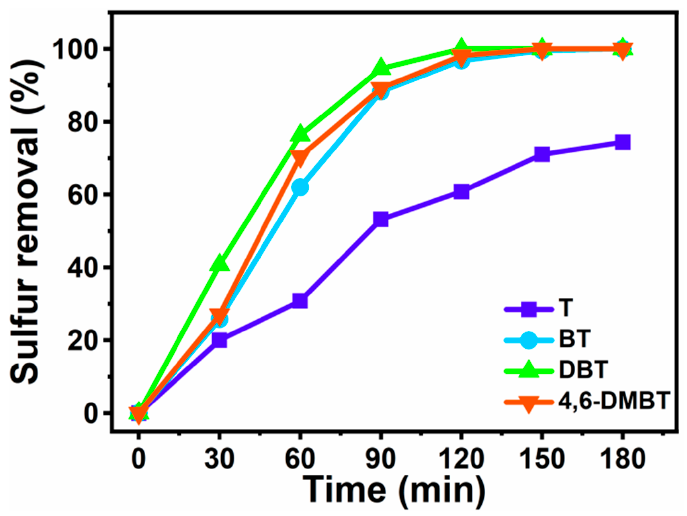
Figure 11. Removal of di ff erent sulfur-containing compounds in the desulfurization system. Experimental conditions: T = 60 °C, V DBT = 5 mL, V IL = 3 mL, O/S = 6, m([BMIM] 3 PMo 12 O 40-based MCF ) = 30 mg, and t = 3 h.